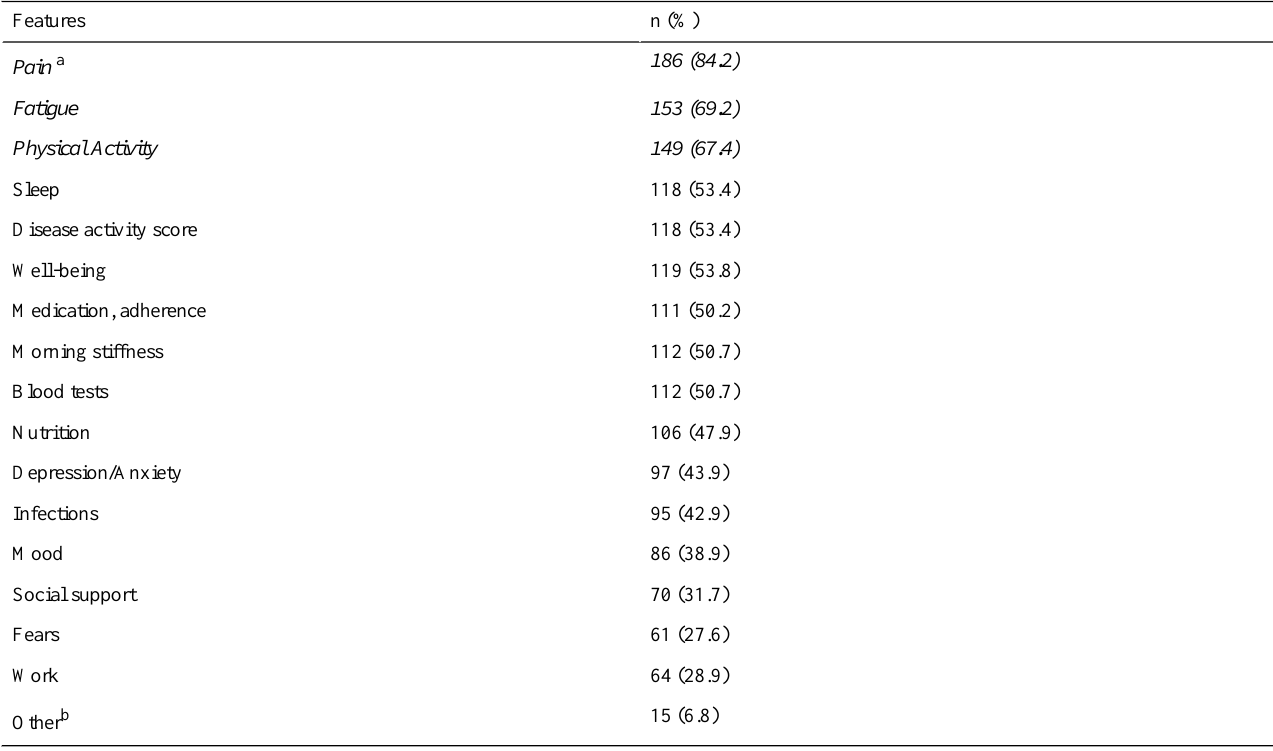
Table 3. Features to be collected by the ideal App (N=345).